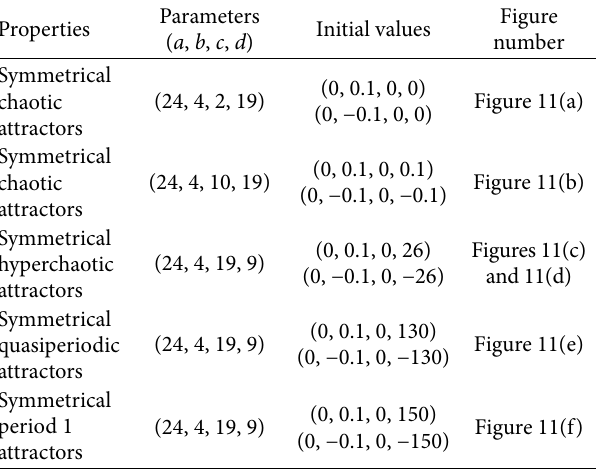
Figure 10: Attractor and power spectrum for (a, b) period‐1; (c, d) period‐2; (e, f) hyperchaos. Table 1: The properties of coexistent attractors under different